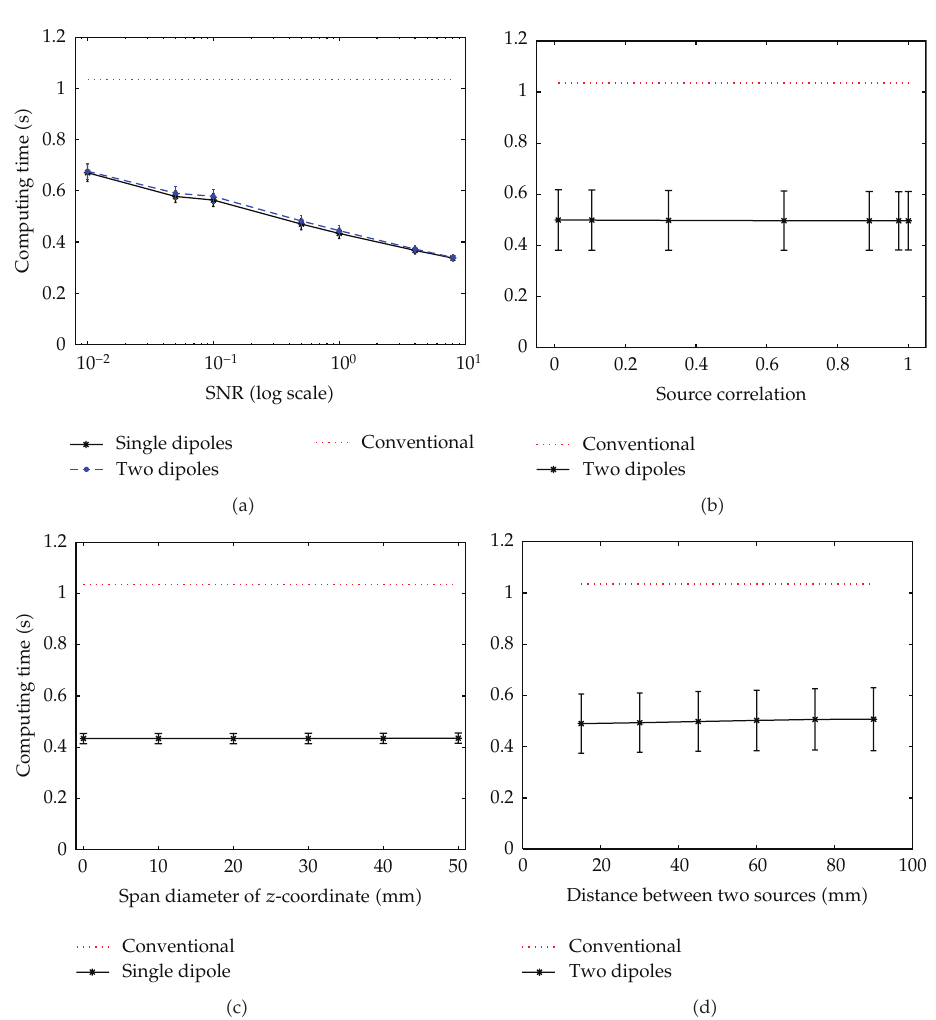
Figure 7: Comparative computational time of our proposed strategy and conventional beamformer over di ff erent problems varying SNR, source correlation, diameter of source, and distance between two sources. Each problem requires a total of 10,000 scanning points and has temporal window of 500 time samples. Each point is the averaged computational time with standard